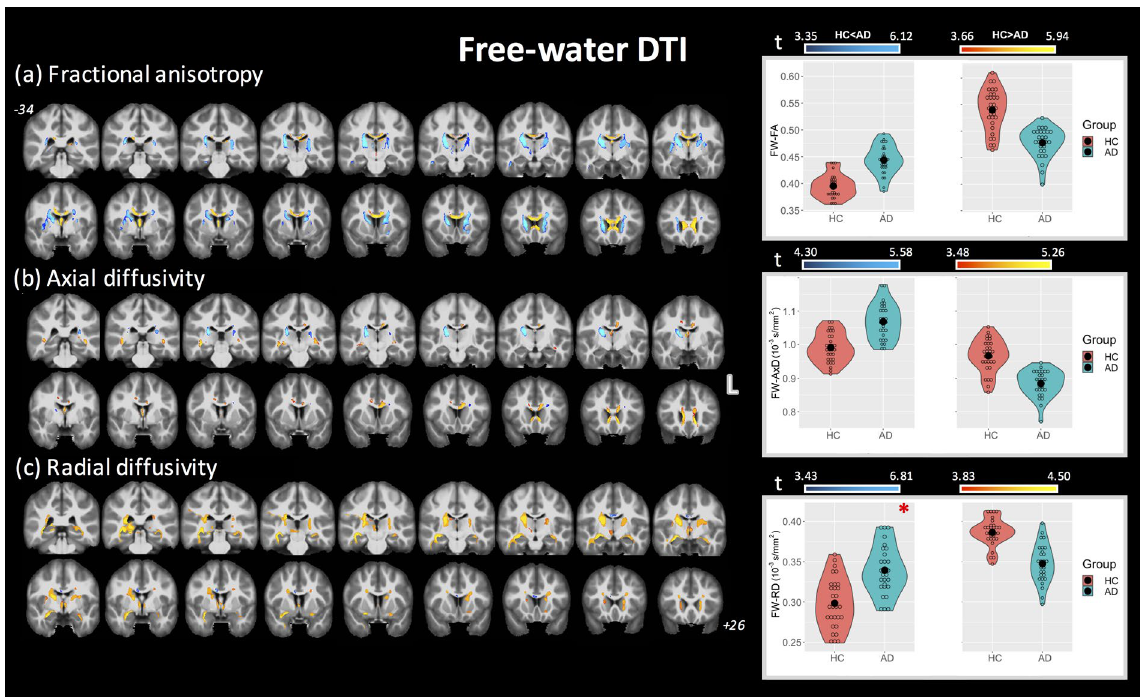
Figure 2. Coronal view of ANCOVA analysis between HC and AD subjects for the FW-DTI metrics. Clusters are reported at a significance threshold of p -value < 0.01 corrected for FWE, except for RD t (HC) < RD t (AD), which is reported at p -value < 0.05 FWE- corrected ( c ) and is indicated by the *. ( a ) FA t , ( b ) AxD t , and ( c ) RD t analysis. The color bars indicate values that are lower in AD than HC (red-to-yellow) and higher in AD than HC (blue-to-cyan). The corresponding violin plots represent the FW-DTI metrics inside the significant clusters for each group.